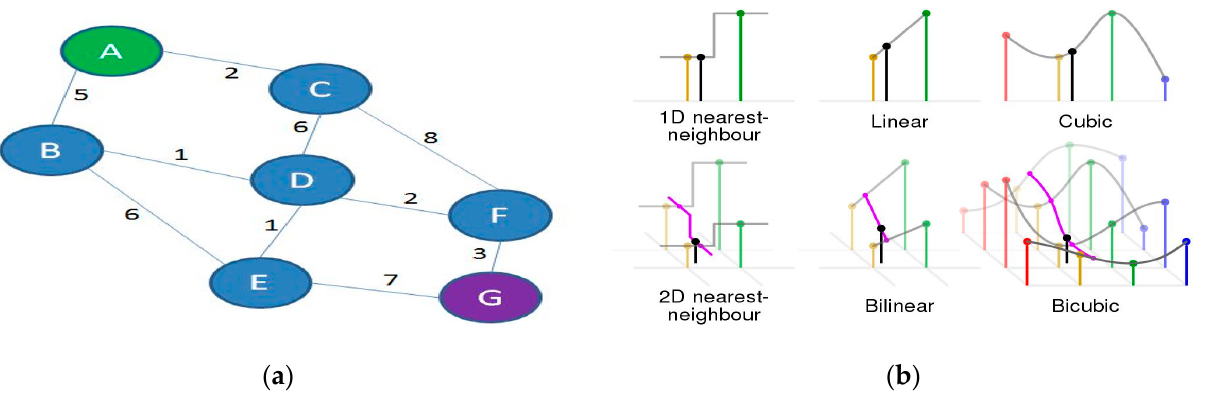
Figure 10. Path optimization and interpolation. ( a ) Path optimization; ( b ) different interpolations.